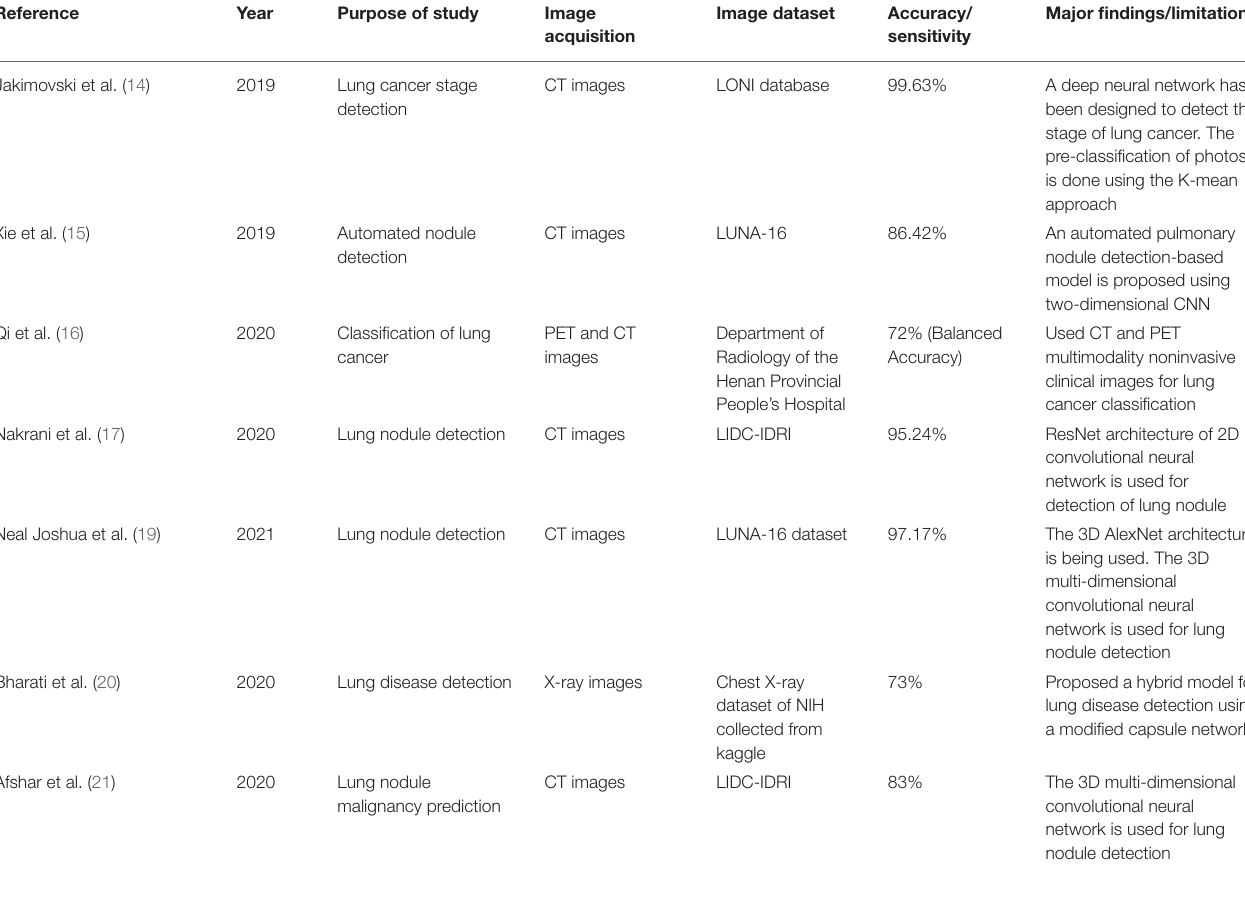
TABLE 1 | Summary of the research articles on lung cancer diagnosis and classification using the DL model by CNN.